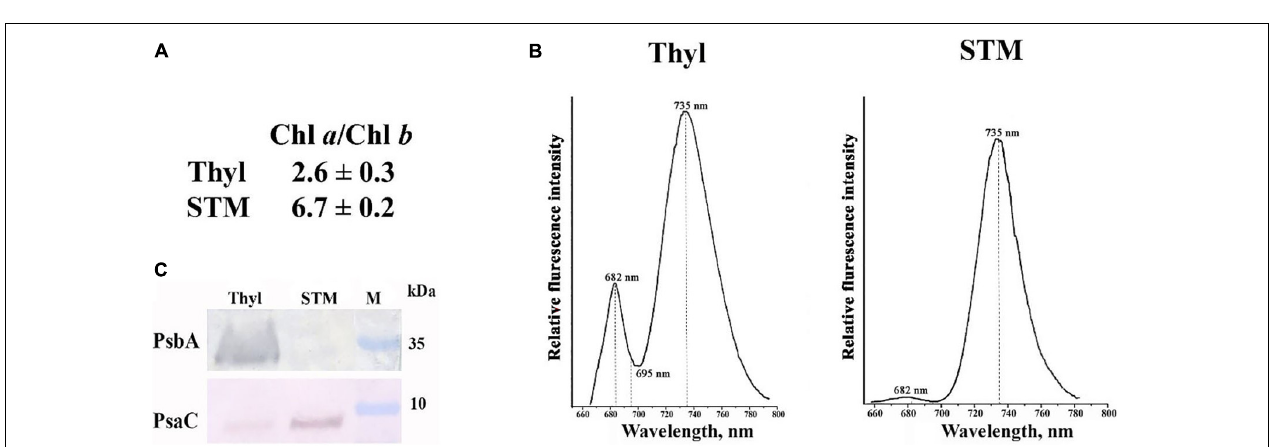
FIGURE 2 | Characteristics of thylakoids (Thyl) and stromal thylakoid membranes (STM) isolated from Arabidopsis thaliana leaves. Chl a /Chl b ratio (A) ; low-temperature chlorophyll fluorescence spectrum of Thyl and STM (B) ; Western blot analysis of the proteins in Thyl and STM with antibodies against PsbA and PsaC, the major proteins of photosystem II (PSII) and photosystem I (PSI), respectively (C) . M, molecular mass markers (kDa).